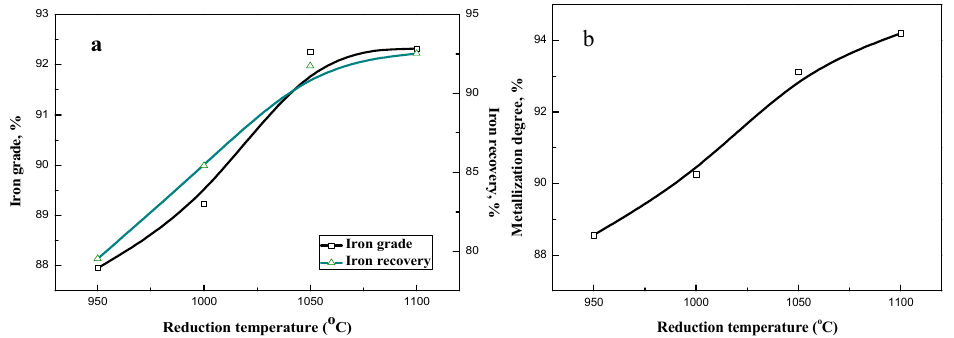
Figure 4. Effect of reduction temperature on iron grade and iron recovery of magnetic concentrate ( a ); and effect of reduction temperature on metallization degree of reduced briquettes ( b ) (borax dosage of 5%, reducing for 80 min, and grinding fineness (<0.044 mm) exceeding 68%).